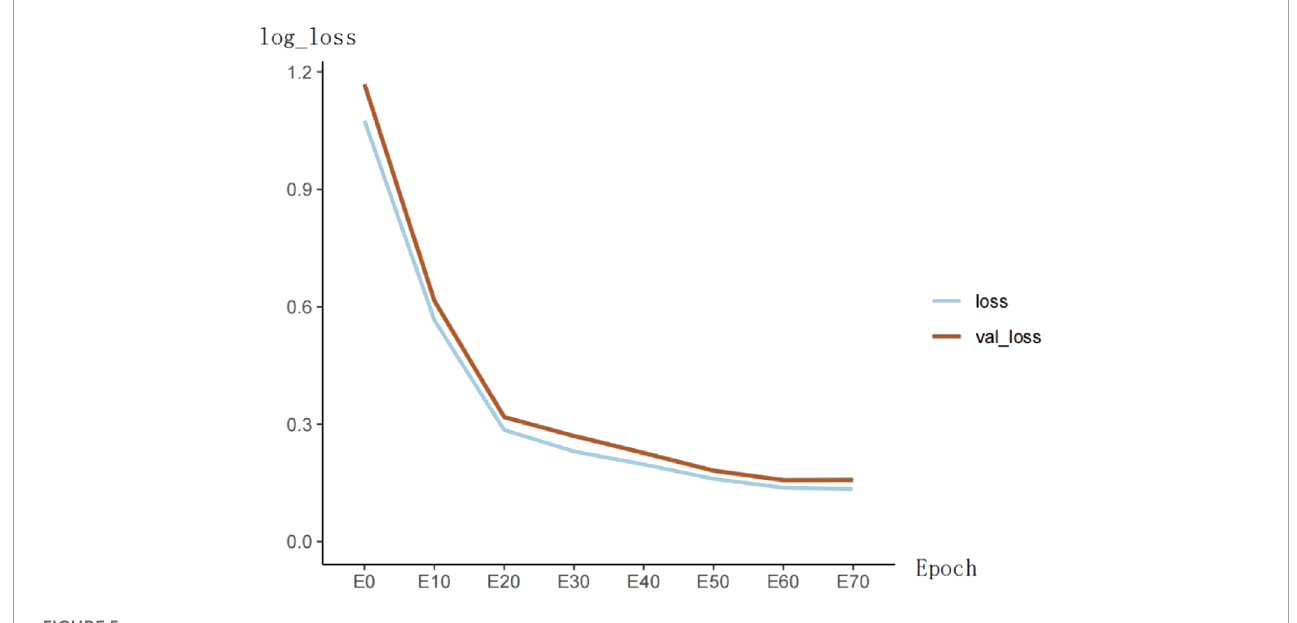
FIGURE 5 Overall structure of the proposed DDFN